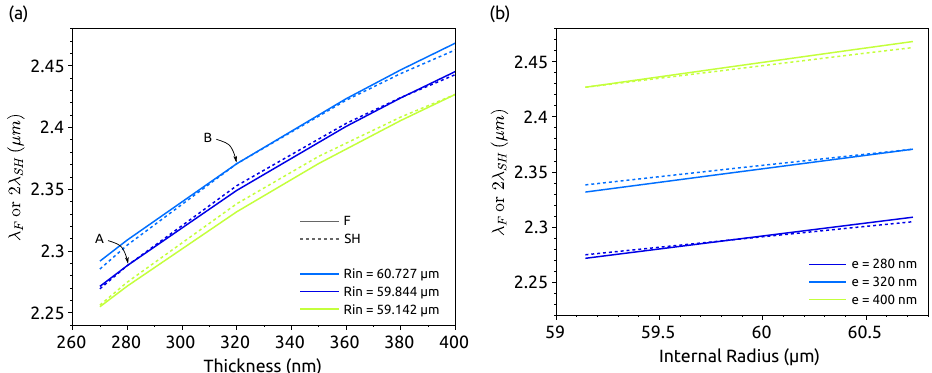
Figure 4. Resonant wavelengths for modes ( m = 400, Hz polarization, p = 1) around 2.3 µ m (labeled as F) and ( m = 802, Ez polarization, p = 3) around 1.15 µ m (labeled as SH) in a Si microring of width w = 800 nm cladded by Si 3 N 4 with respect to ( a ) the thickness e and ( b ) the internal radius R in . Please note that the notations F and SH are chosen for the sake of simplicity but really correspond to fundamental and SH only at the crossing points. The colors are the same as in Figure 2b to make the correspondence easy, and an example of correspondence is given with points A and